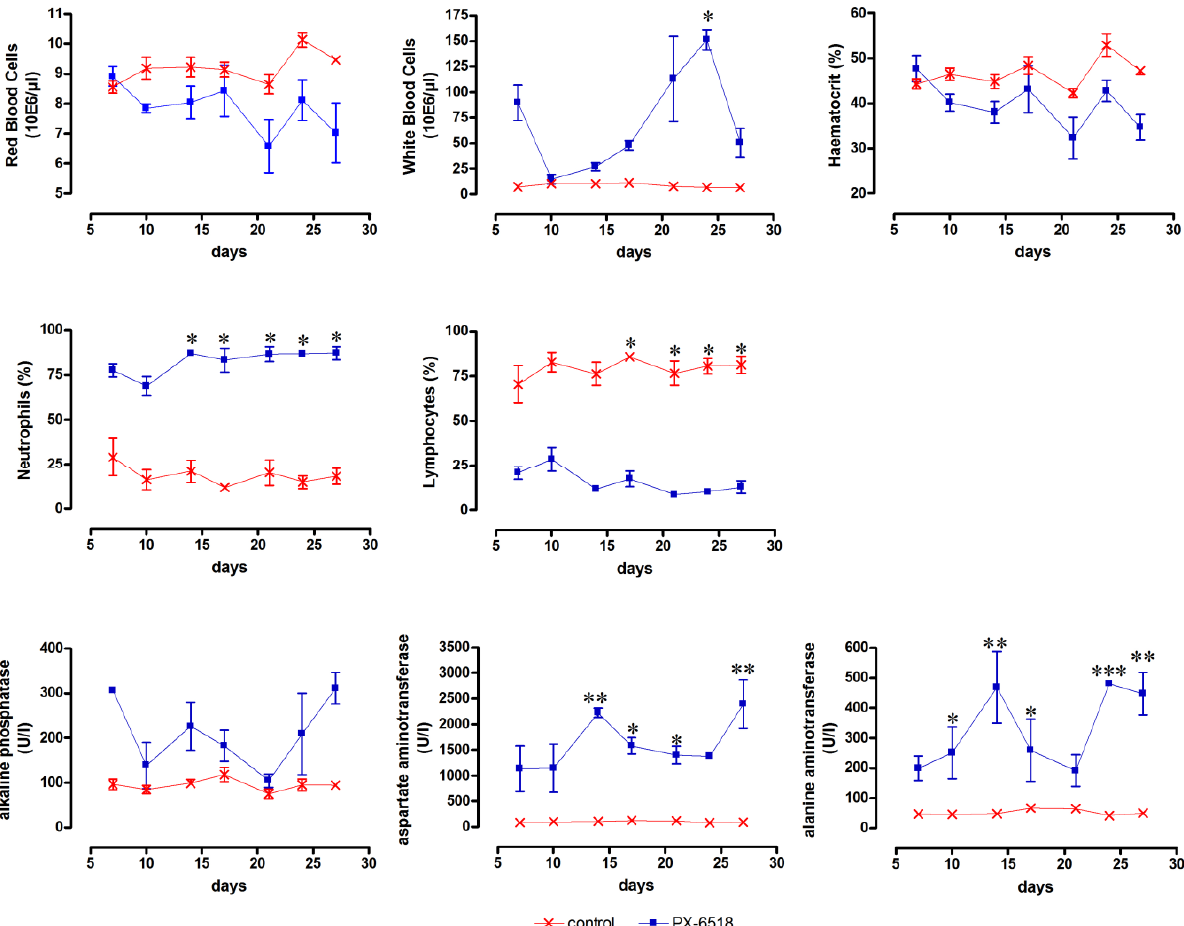
Figure 1. Monitoring of target toxicity parameters (red blood cells, white blood cells, haematocrit, neutrophils, lymphocytes, alkaline phosphatase, aspartate aminotransferase and alanine aminotransferase) in mice after SC dosing at 20 mg/kg for 5 consecutive days. (n = 3 for each time point) * p < 0.05, ** p < 0.01 and *** p < 0.001 (two-way ANOVA with Bonferroni post-hoc